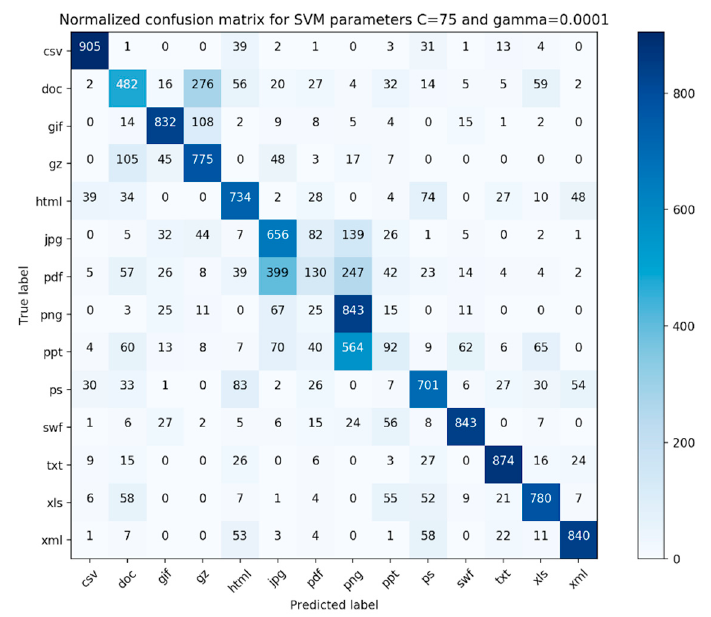
Figure 6. Confusion matrix for the classification of the files using hierarchy 2. Table 5. Classifier results for hierarchy